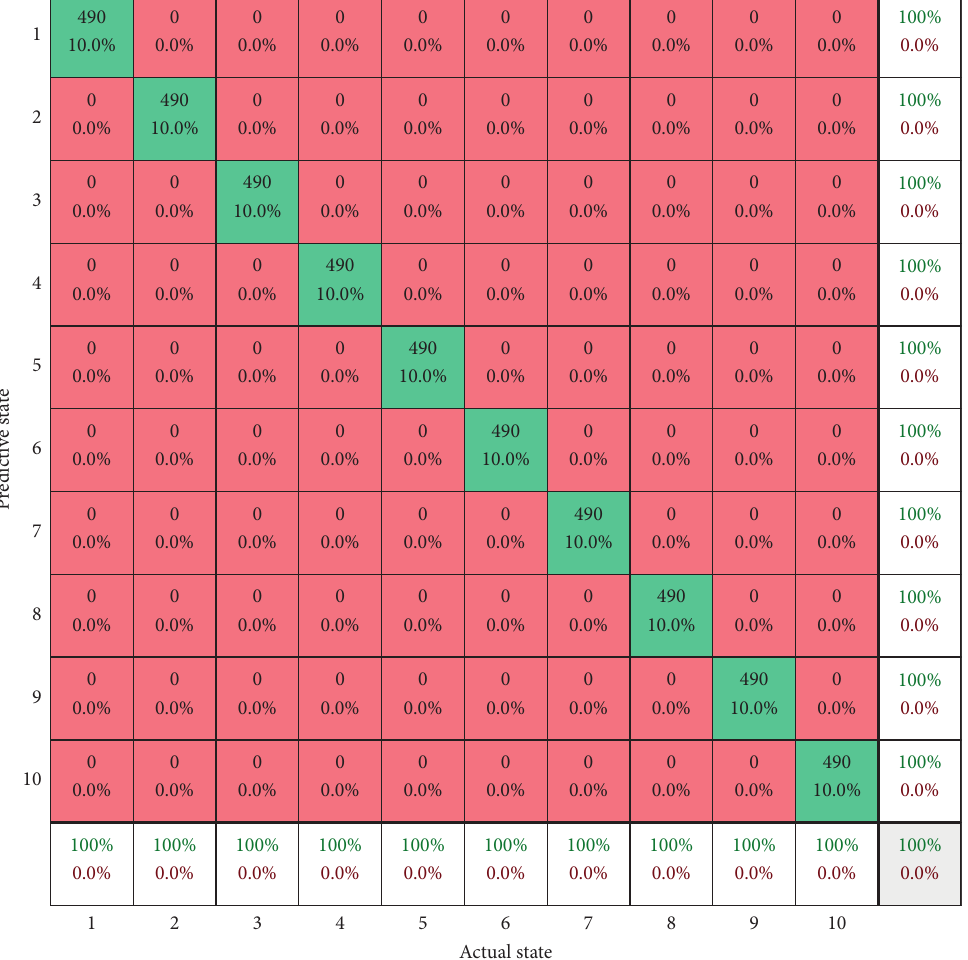
Figure 4: Confusion matrix of fault recognition for rolling bearing training samples based on the DMN-Yu model.